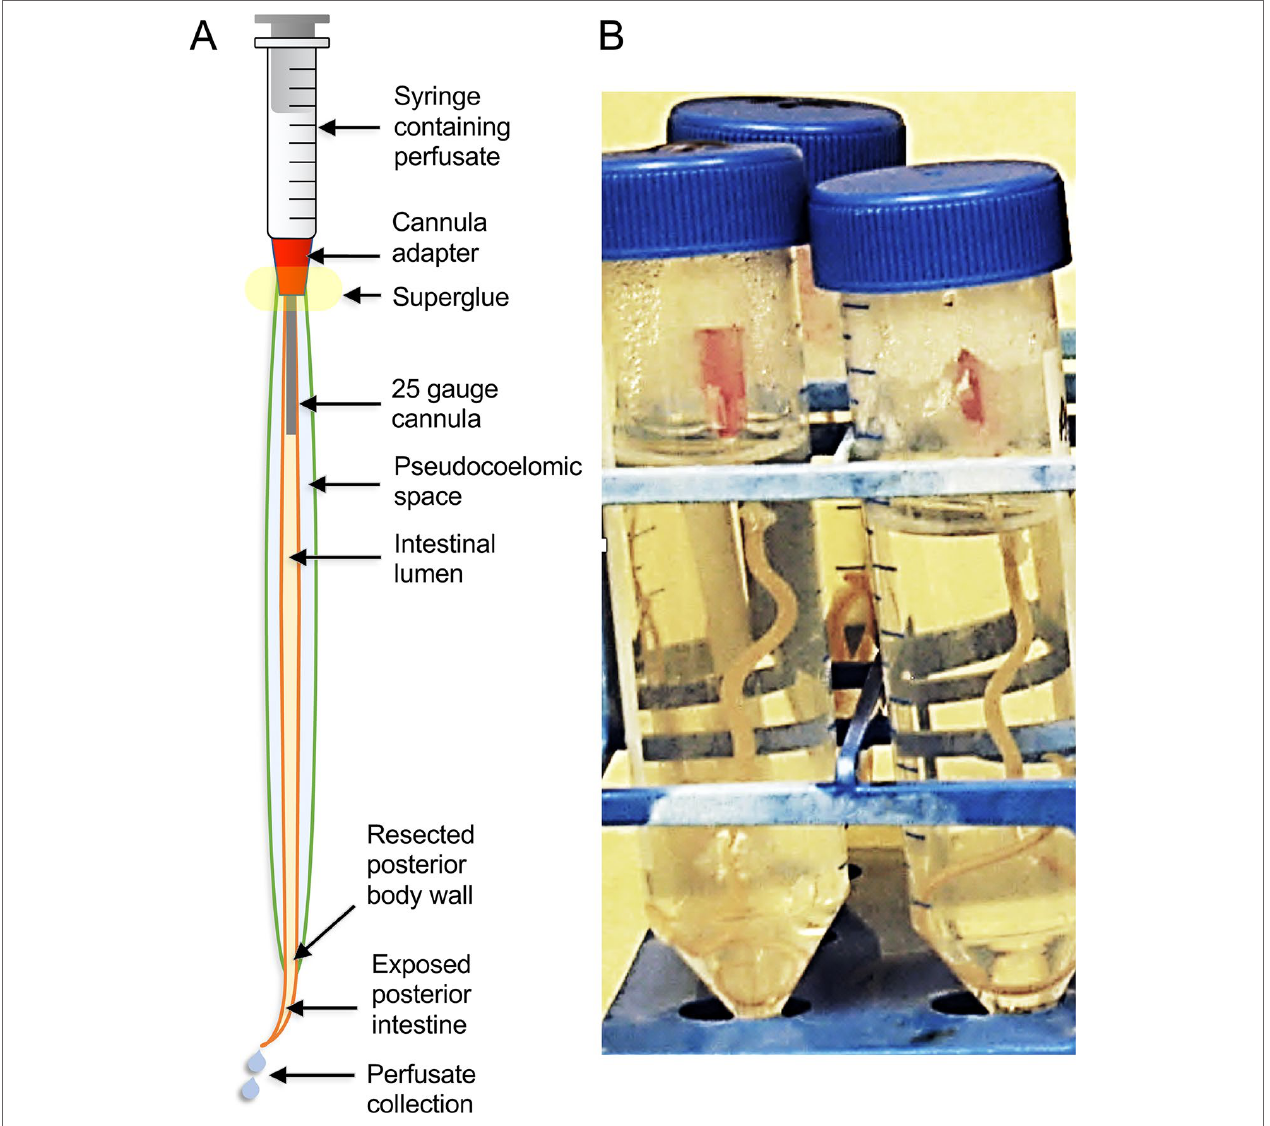
FIGURE 5 | The A. suum intestinal cannulation and perfusion system. Shown are (A) a diagram description of the system and (B) a picture of the actual worms set up in the system, and contained inside of plastic test